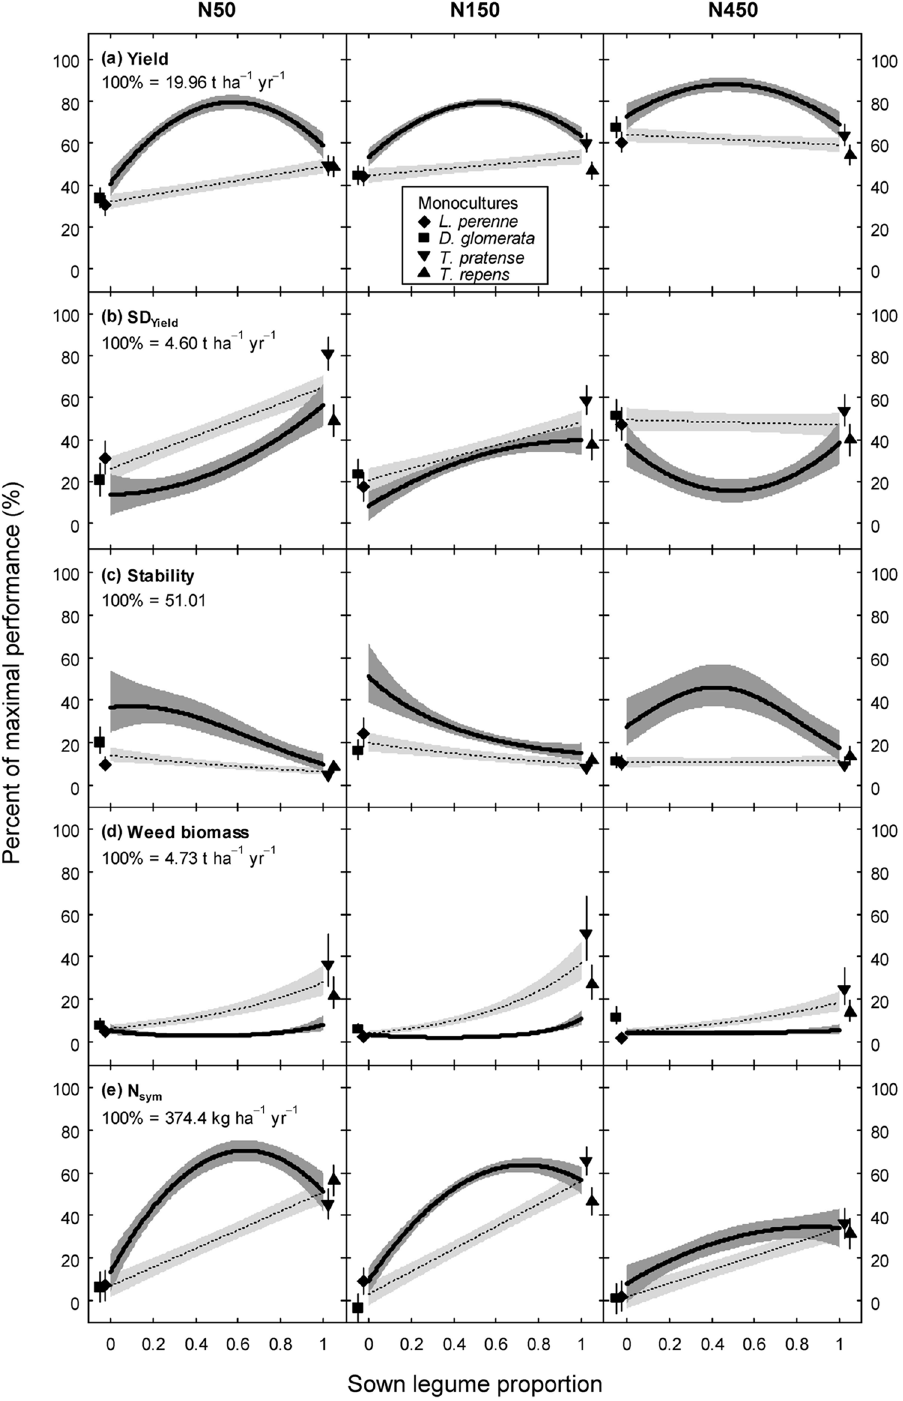
Figure 1. Predicted performance (bold lines, ± 1 s.e. dark grey shaded) of ten functions ( a – k ) in dependence on legume proportion at three N fertilisation treatments, data averaged across years (scaled in % of the maximal performance per function at a single year over the three-year experiment and N fertilisation treatments; N50: 50 kg N ha −1 yr −1 , N150: 150 kg N ha −1 yr −1 , N450: 450 kg N ha −1 yr −1 ). Predictions and s.e. are based on multivariate regression analysis (Table 2); the underlying model (Eq. 3) explained 88% of the variation in the data (see Supplementary Table S2). Lines display mixtures that are comprised of equal proportions of the two grass and the two legume species, meaning that predictions at a legume proportion of 0.5 are for the four-species equi-proportional mixture and at the left and right endpoints of lines for binary mixtures. Predicted performance of monocultures (± 1 s.e.) is indicated by symbols. Dotted lines display the functional performance (± 1 s.e. light grey shaded) that can be expected from the weighted average of monocultures in the absence of any diversity effect. Stability, weed biomass, and NO 3 in soil solution are back-transformed to linear scale. The large upper s.e. for the monoculture in panel g) is truncated and reported as a number, and the intermediate gray in g) indicates the cross-section of the two s.e. bands. See Supplementary Fig. S6 for observed versus predicted